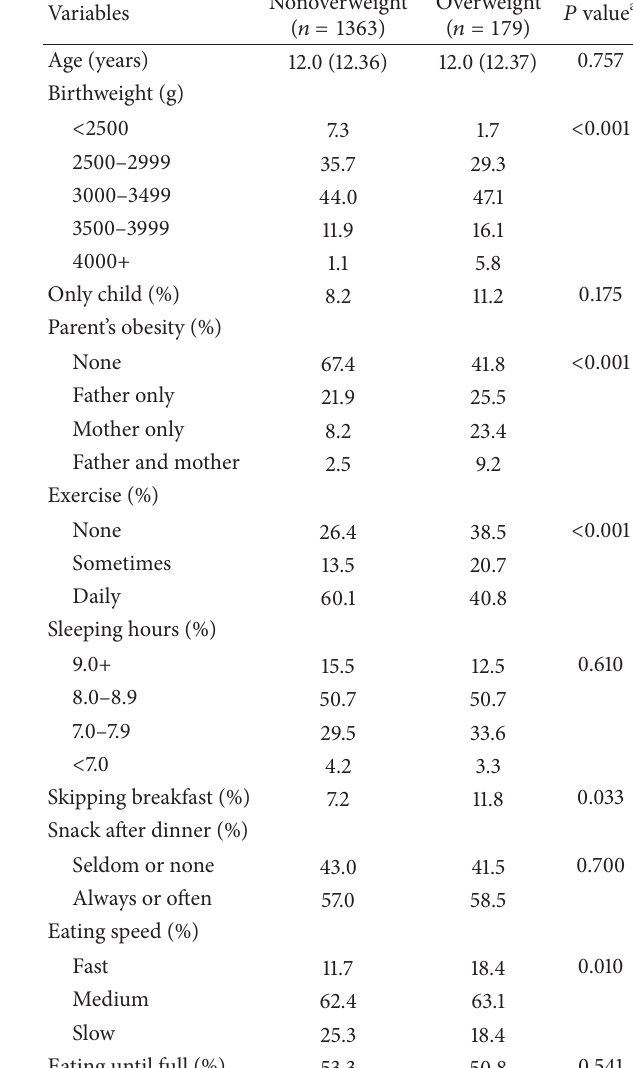
Table 2: Characteristics of the nonoverweight and the overweight girls among study